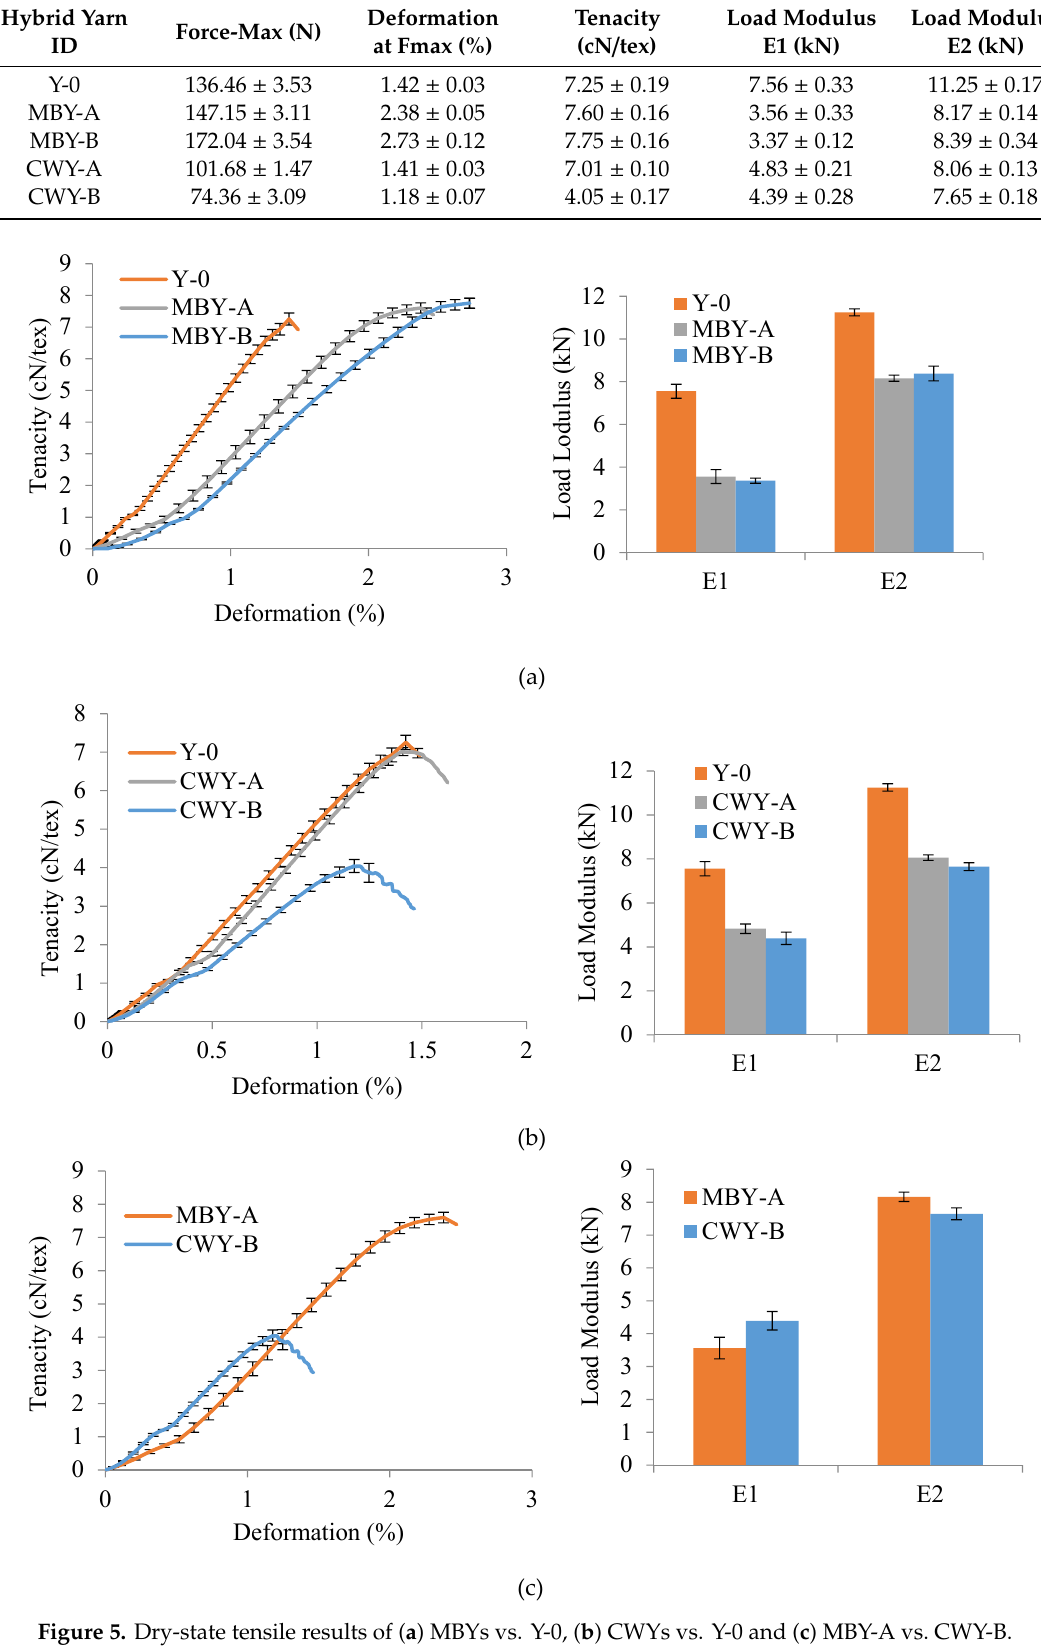
Table 3. Dry-state tensile properties of MBYs and CWYs.